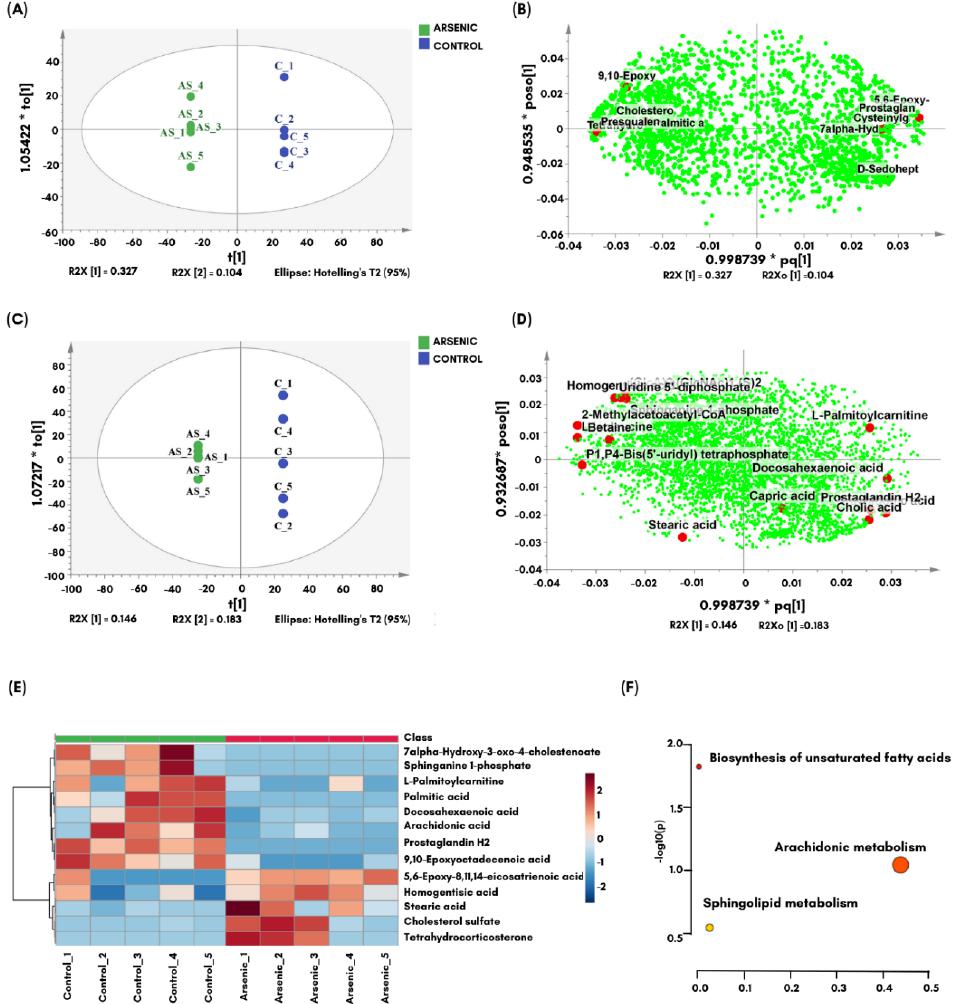
Figure 5. OPLS − DA score plot and loading scatter plot ( A , B ) of negative and positive ( C , D ) modes based on the zebrafish larvae normalized data exposed to 30 µM As 2 O 3 in comparison to control larvae . ( E ) Differential expression of metabolites in As 2 O 3 − exposed larvae produced by hierarchical clustering of the most significantly upregulated (red) and downregulated (blue) metabolites obtained from in negative- and positive-ion modes compared to the control group based on the log2 fold change value. ( F ) Metabolic set enrichment analysis of lipid metabolites in 6 dpf zebrafish showed the biosynthesis of unsaturated fatty acids, arachidonic metabolism, and sphingolipid were dysregulated after embryonic exposure to As 2 O 3 . Color intensity (yellow − to − orange/red) represents increasing statistical significance, whereas circular diameter is related to pathway impact. The graph was obtained by plotting − log of p -values from pathway enrichment analysis on the y -axis and the pathway impact values derived from pathway topology analysis on the x -axis. The potential biochemical biomarkers for the long-term effects of As 2 O 3 compared to control larvae were further computed using a supervised OPLS-DA analysis (score and loading plots of negative (Figure 5A,B) and positive (Figure 5C,D) mode) to correlate the changes in metabolites in As 2 O 3 -exposed larvae with neurotoxicity and behavioral abnor- malities. The generated OPLS-DA score plot shows significant differences between the As 2 O 3 -exposed zebrafish larvae and the control groups (Figures 5A,C). In negative mode, four components were produced (Figure S9A,B) with acceptable goodness of fit and